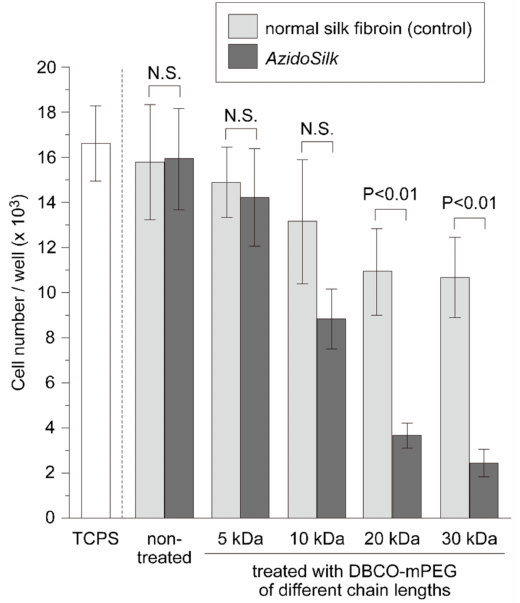
Figure 4. Number of adherent NIH3T3 fibroblasts on the surfaces of normal silk fibroin and AzidoSilk films when treated with DBCO-mPEG of di ff erent chain lengths. Fibroblasts were cultured for 2 h at 37 ◦ C in Eagle MEM (minimum essential media) without FBS (fetal bovine serum). Cells were counted by the lactate dehydrogenase (LDH) method and the results were averaged. The error bars represent standard deviation ( n = 8 for TCPS and n = 4 for the others). Statistical significance by the Tukey–Kramer test is shown. N.S. denotes no statistical significance ( p >